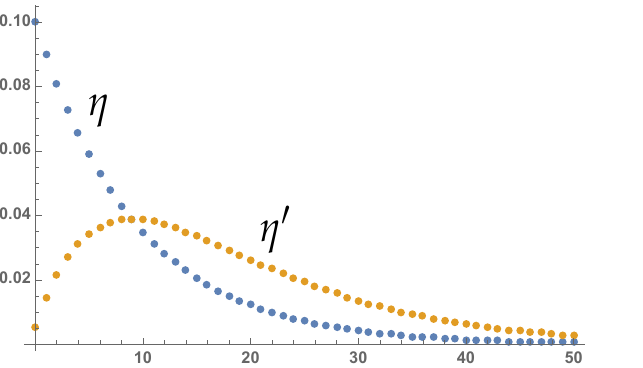
Figure 8. Normalized eigenvalues η and η (cid:48) (of W e L in Equations (45) and (46), respectively), as functions of the index n for q =